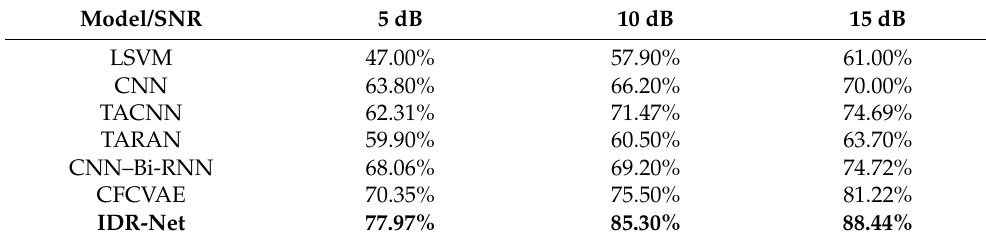
Table 8. Comparisons of the recognition accuracy under different